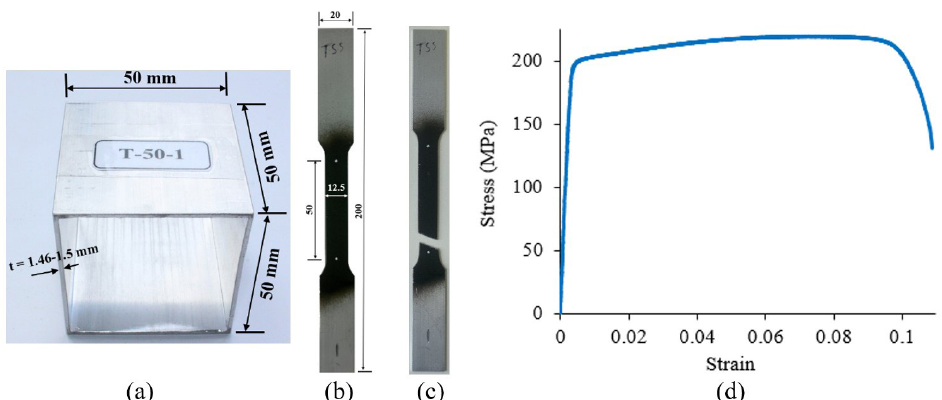
Figure 1. (a) A photograph of aluminium tube with dimensions; (b) tensile test coupon before the test with dimensions by following ASTM E8/E8M standard; (c) coupon after tensile test; (d) engineering stress-strain curve of the aluminium coupon from tensile test 33